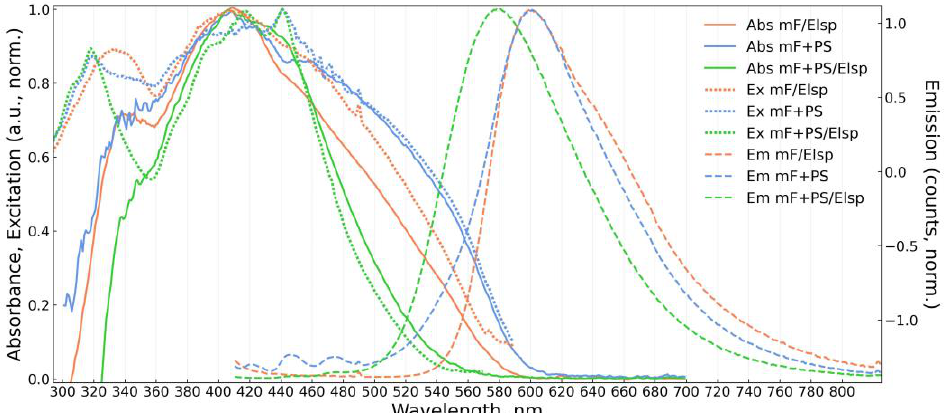
Figure 6. Absorbance (Abs, solid), excitation (Ex, dotted), and emission (Em, dashed) spectra of obtained solid fluorescent material mF/Elsp (electrospun 5 × 10 −3 M fluorophore solution) and materials mF+PS , mF+PS/Elsp (drop-casted and electrospun solutions containing 1 × 10 −3 M and 2 × 10 −3 M of the fluorophore, respectively).